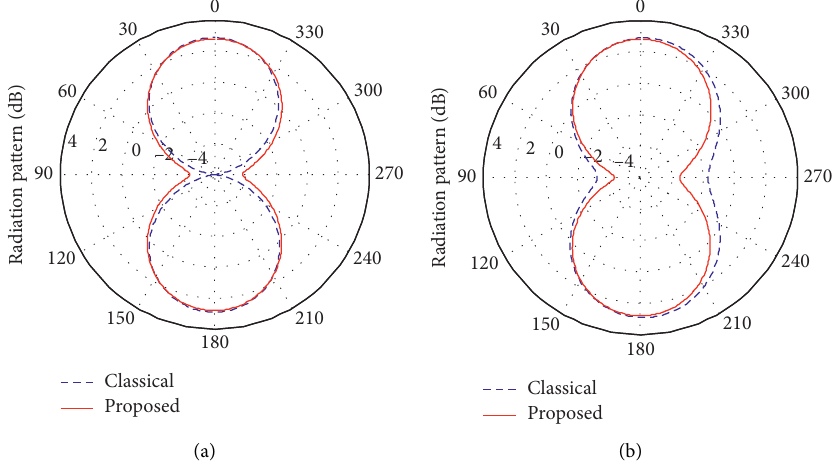
Figure 6: Simulated radiation patterns. (a) xoz plane at 0.8GHz. (b) yoz plane at 0.8 GHz.